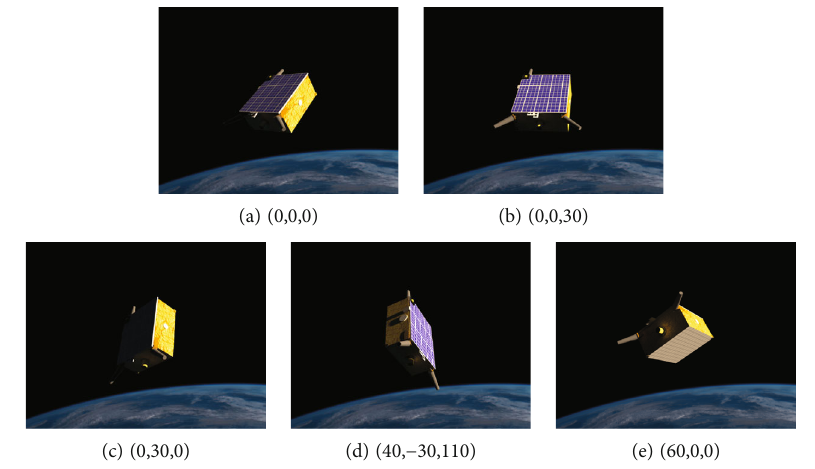
Figure 10: Visible images of di ff erent pose — unit ( ° ).